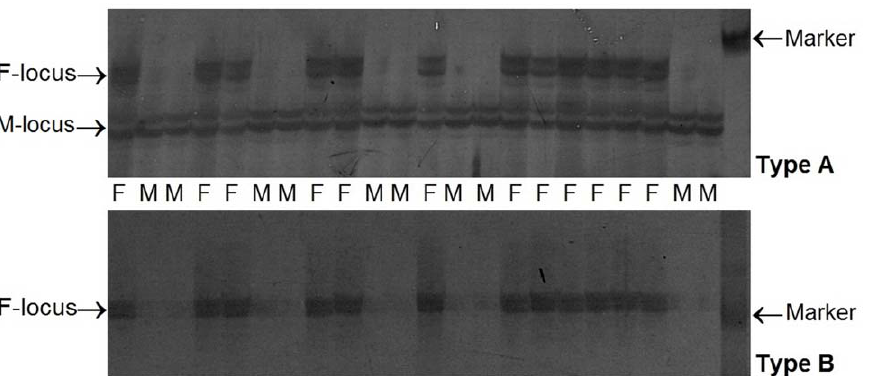
Figure 1. Polyacrylamide gel separation of sex-linked microsatellites PCR amplification products in females and males. Type A: Marker F-locus was only present in females, and marker M-locus present in females and males. Type B: Marker F-locus was only present in females, and marker M-locus absent in all individuals.